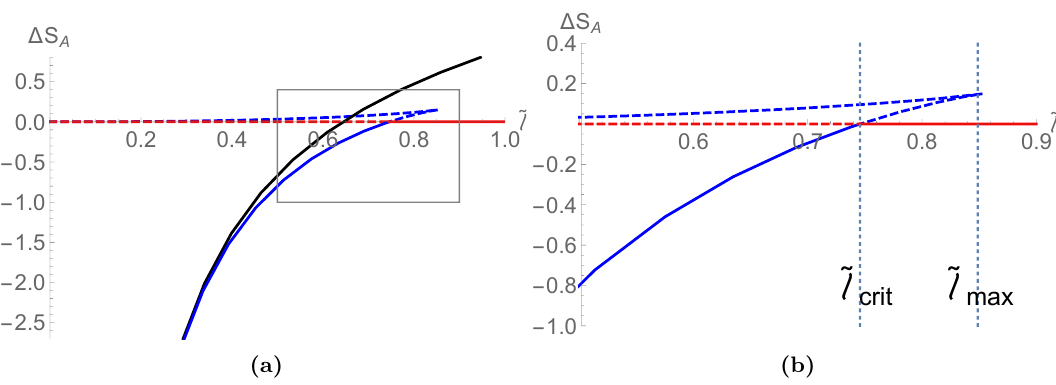
Figure 7. HEEs for an AdS Q-Soliton and a Q-lattice black brane. These (cid:12)gures depict HEE curves in the background geometry corresponding to the blue dot in (cid:12)gure 5. The black solid line in (a) shows the entanglement entropy curve for the Q-lattice black brane, where the values were subtracted by S (discon) . The blue and red solid lines show the entanglement entropy for the AdS A Q-soliton. One can notice that there is a drastic change at ~ l = ~ l crit . The (cid:12)gure (b) is the enlarged view of the rectangle in (a). The blue lines show the HEE given by the connected surface and the red lines are nothing but S (discon) of the disconnected A